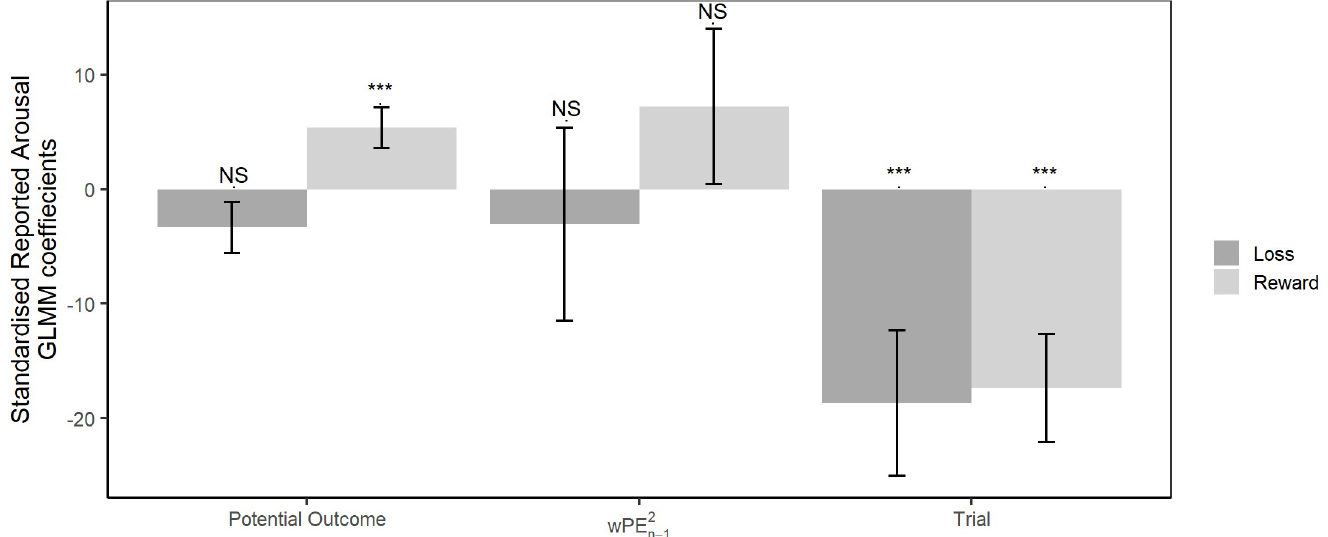
Fig 4. Arousal GLMM coefficients. Standardised GLMM coefficients from the model of reported affective arousal for both the fluctuating reward and fluctuating loss condition. Positive values for the standardised GLMM coefficients reflect a positive relationship between reported arousal and the predictor variable, while negative values reflect a negative relationship. Error bars represent one standard